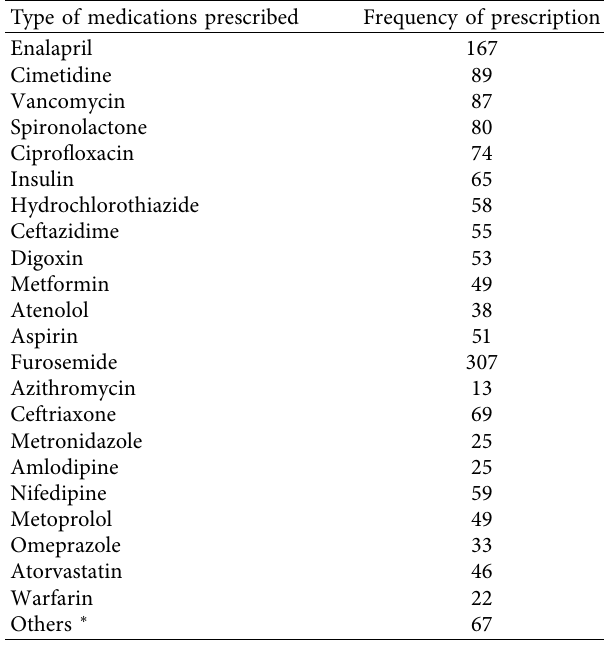
Table 4: Frequency of medications prescription in patients with renal impairment admitted to medical wards at Amhara region referral hospitals, Amhara, Ethiopia, in 2020 ( n � 424).